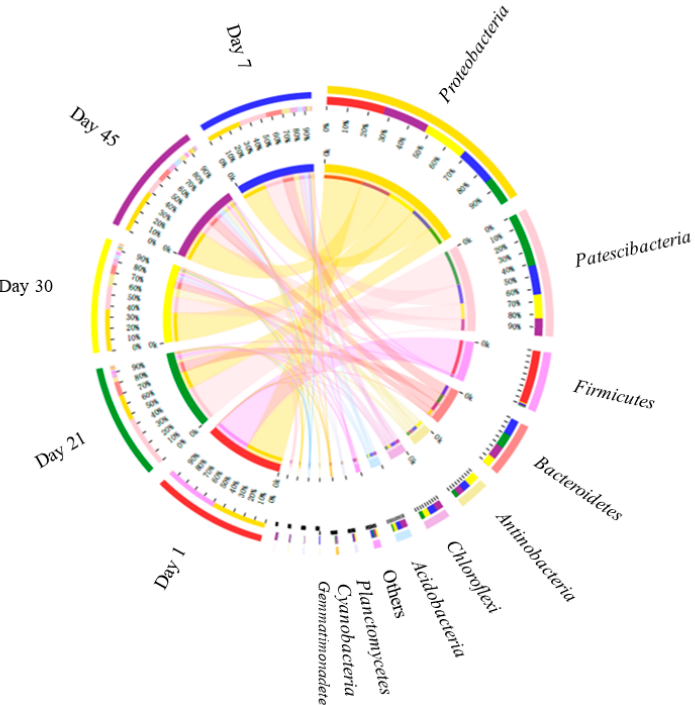
Figure 4. The composition of dominant species in the reactor at different periods and their distribution in the samples (the left half circle shows the species composition in the sample, the color of the outer ribbon represents the group from which it comes, the color of the inner ribbon represents the species, and the length represents the relative abundance of the species in the corresponding sample. The right half circle shows the distribution of the species in different samples at the taxonomic level, the outer ribbon represents the species, the color of the inner ribbon represents different groups, and the length represents the distribution of the species in a given